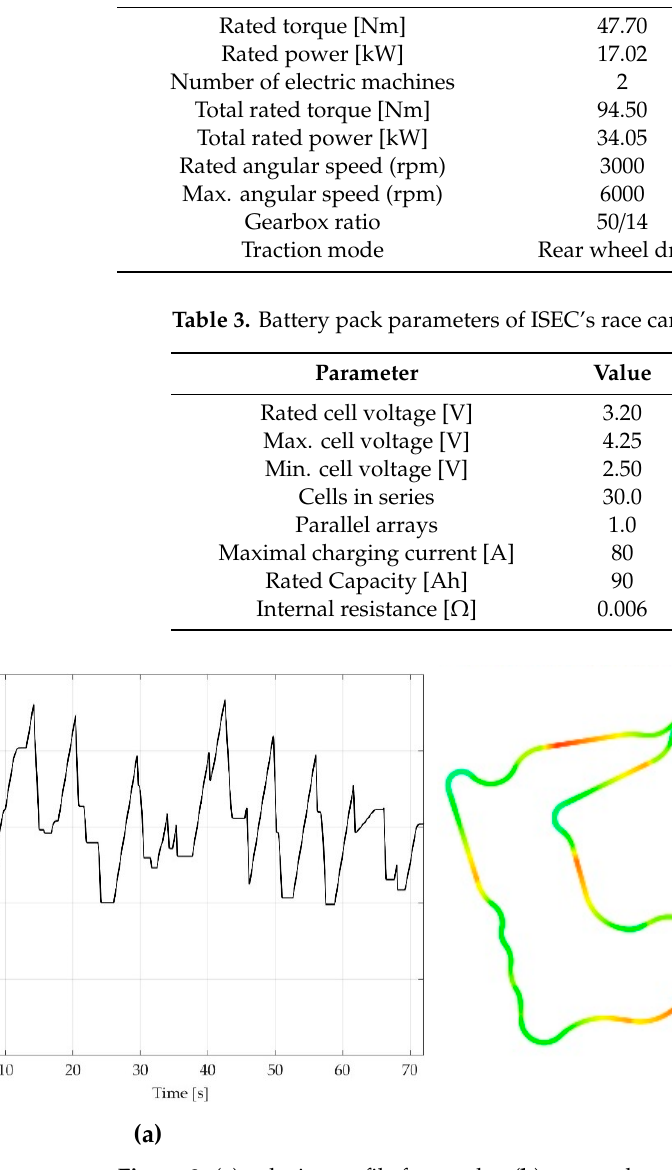
Figure 9. (a) velocity profile for one lap (b) racetrack map [37]. Figure 9. ( a ) velocity profile for one lap ( b ) racetrack map